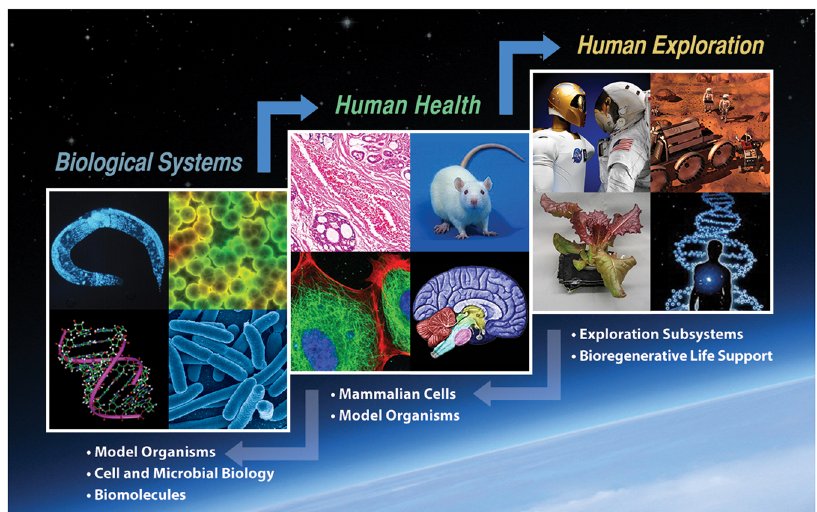
Fig. 1 The NASA Life Sciences Translational Path. It moves from basic research to human exploration applications with bi-directionality options. As knowledge is applied along this path ( top arrows ) questions may arise that can best be addressed by more basic research ( bottom arrows ) in order to support further progress toward successful human